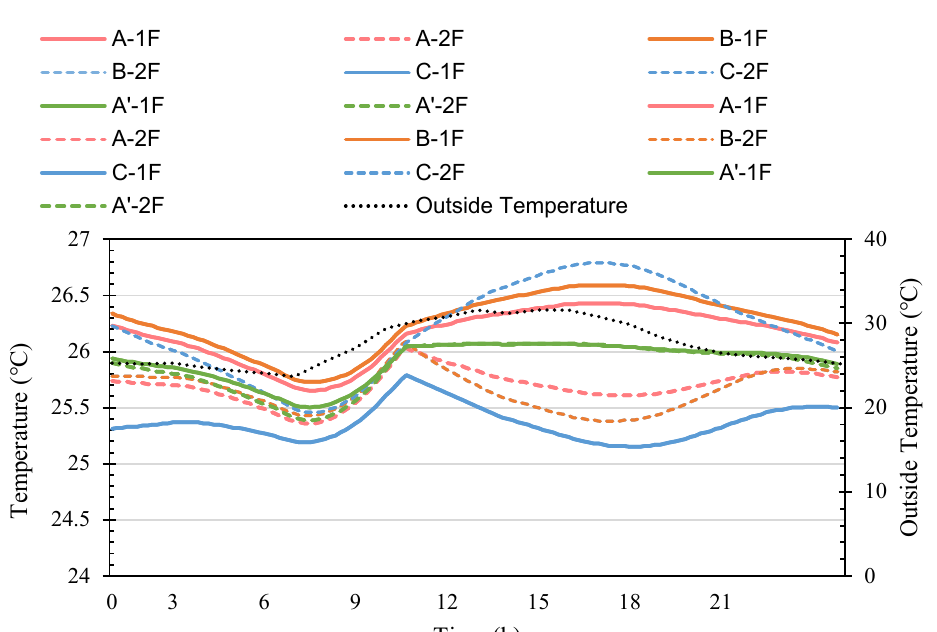
Figure 14. Room temperature change over time in the This is what happens when you set it to minus (-) in Excel. It is impossible to fix.first-floor living area (Zone 4) and second-floor room (Zone 6).